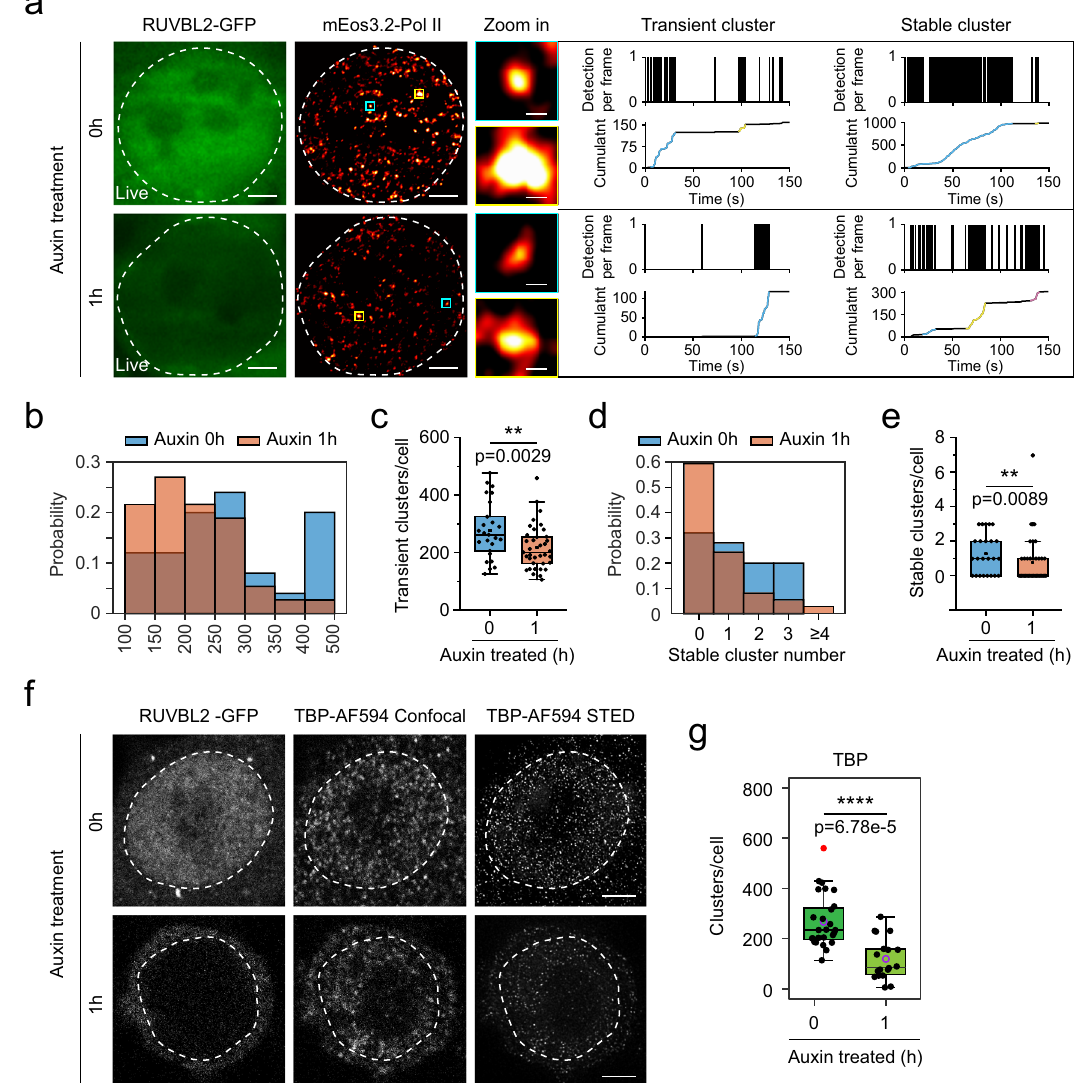
Fig. 3 | RUVBL2 regulates the preinitiation Pol II clusters. a Super-resolution image of endogenous Pol II labeled with mEos3.2 in living RUVBL2 and degron mESCs (left) and representative images of transient and stable Pol II clusters and corresponding time-correlated photoactivation localization microscopy (tcPALM) traces(right).TransientandstablePolIIclusterscorrespondtoareasboxedinblue and yellow, respectively. The dashed box indicates the nucleus; scale bars, 1 μ m in the whole-cellinthe super-resolution image(left),and 200nminthe transientand stable Pol II cluster images (right). b The distributions of the number of transient PolIIclustersbeforeandafterRUVBL2degradation. c Thetransientclusterspercell ( n =25 for auxin treatment at 0h and n =37 for auxin treatment after 1h) were calculated, and two-tailed Student ’ s t tests were performed for determining sta- tistical signi fi cance (box plot), ** p <0.01. d The number of stable Pol II cluster